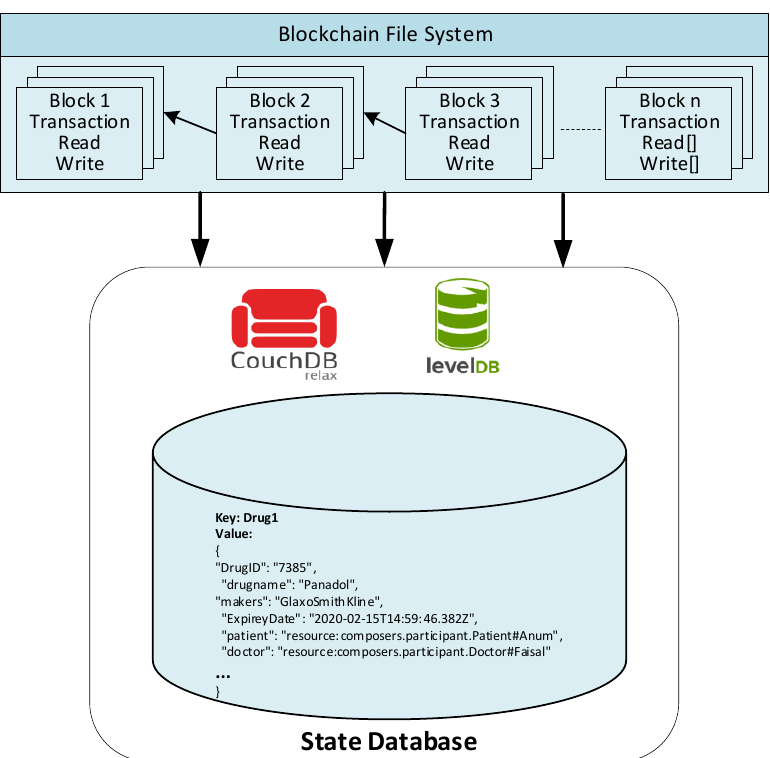
Figure 14. Distributed ledger of the proposed drug supply chain management in a medical blockchain